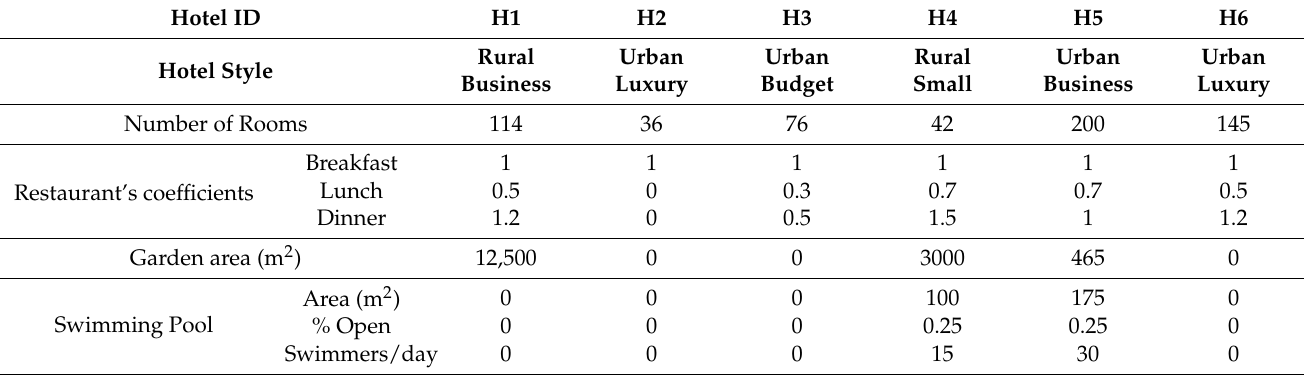
Table 16. Hotels’ main